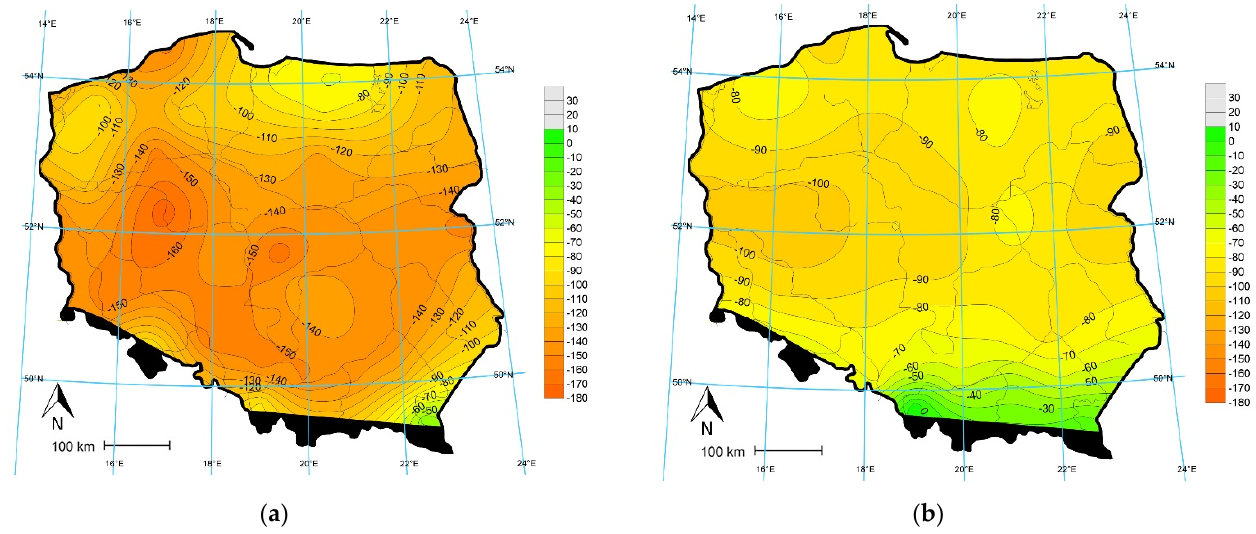
Figure 4. Climatic water balance (CWB) in June: ( a ) 2019; ( b ) 1981–2010. Explanation same as in Figure 2.